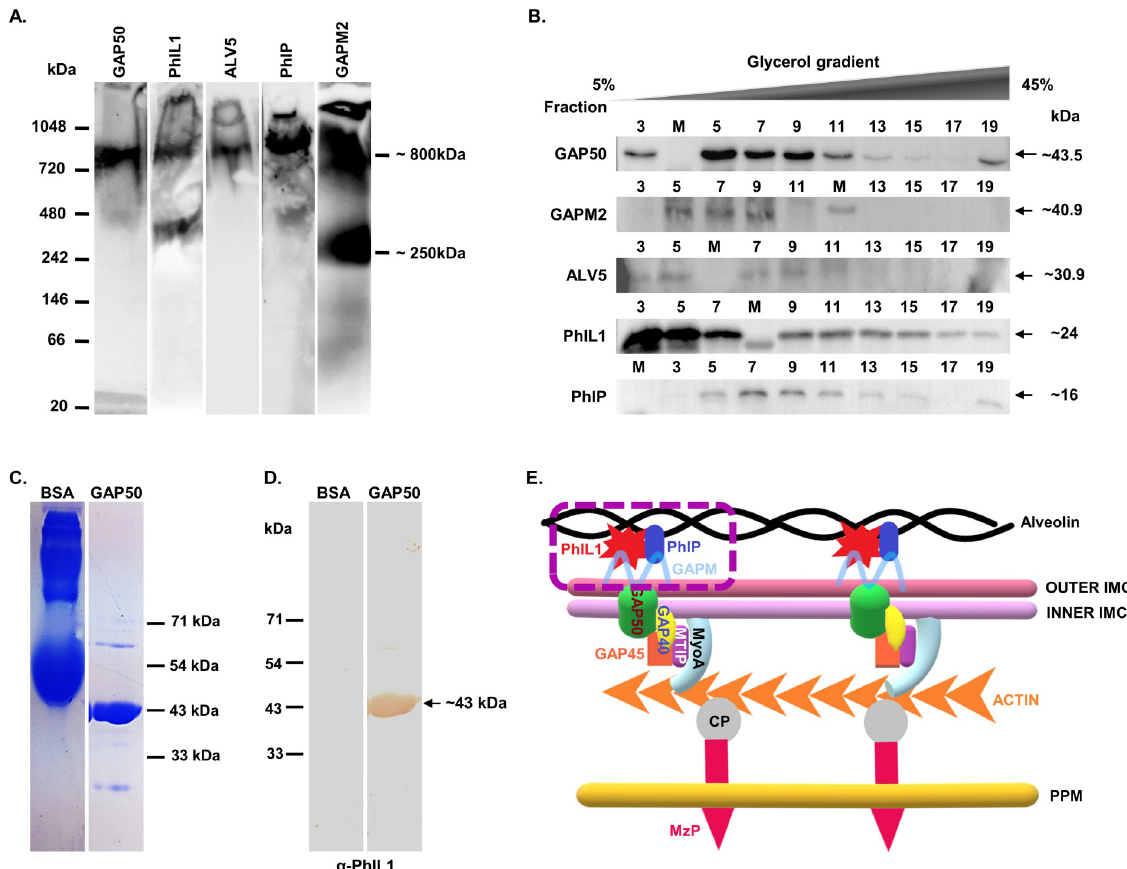
Fig 2. PhIL1-associated novel complex overlaps with components of the linear motor in the IMC but is a separate complex. (A) Native PAGE analysis of schizont stage parasite lysate shows co-existence of PhIL1-associated complex with the glideosomal complex via. some overlapping components. A complex of * 800 kDa was detected containing components of PfPhIL1-associated complex and GAP50. Furthermore, a smaller complex of * 250 kDa was also detected that included PfPhIL1 and PfGAPM2. These results indicate a possible association of PhIL1-associated complex and glideosomal complex. n = 2 experiments. (B) PhIL1-associated complex co-exists with the glideosomal complex as seen by Glycerol gradient co-sedimentation analysis. Glycerol gradient fractionation of P . falciparum schizont extract using 5 to 45% Glycerol gradient followed by immunoblotting of the fractions using specific antibodies showed the co-sedimentation of PfGAP50, PfPhIL1, PfALV5, PfPhIP, and PfGAPM2 together in fractions 5 to 11, particularly, in fraction 9 corresponding to * 250 kDa molecular mass. n = 2 experiments. (C) Recombinant GAP50 and BSA were subjected to SDS-PAGE followed by (D) far western analysis showing the interaction of recombinant PfGAP50 protein with PfPhIL1. GAP50 was denatured and renatured on the membrane followed by incubation with recombinant PhIL1 protein and probed with α -PhIL1 antisera which recognized a band of ~43kDa corresponding to the size of GAP50. BSA used as control protein did not show any interaction with PfPhIL1. (E) Model showing molecular motor and partially overlying proposed PhIL1-associated complex (dotted box) in the parasite IMC. Photosensitized 5-[ 125 I] Iodonaphthalene-1-azide Labelled Protein-1 (PhIL1); Ph IL1 I nteracting P rotein (PhIP); Glideosome-Associated Protein 40, 45 and 50 (GAP40, 45 and 50); Glideosome- associated protein with multiple membrane spans (GAPM); myosin-A (MyoA); Myosin-A Tail domain Interacting Protein (MTIP); Connector Protein between actin and protein of the merozoite surface (CP); Protein of the Merozoite surface (MzP); Parasite Plasma Membrane